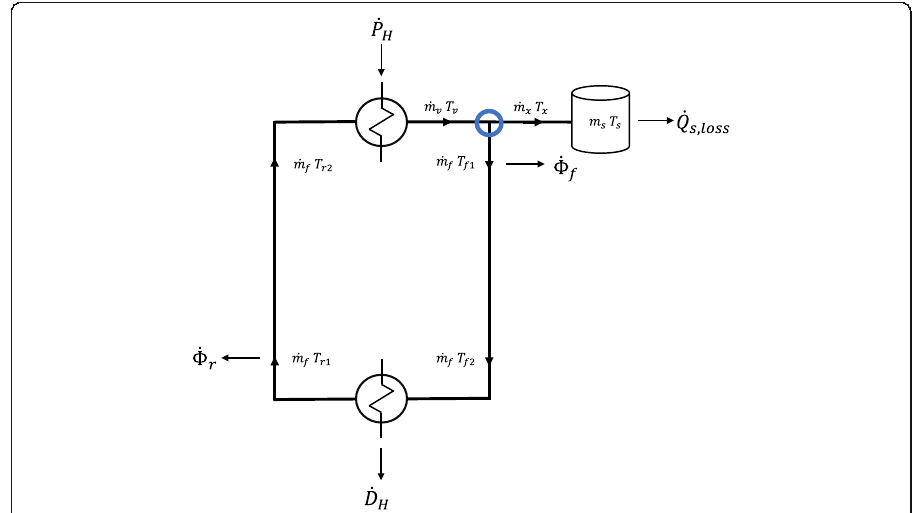
Fig. 1 Illustration of the district heating system modeled showing the production side at the top and the demand side at the